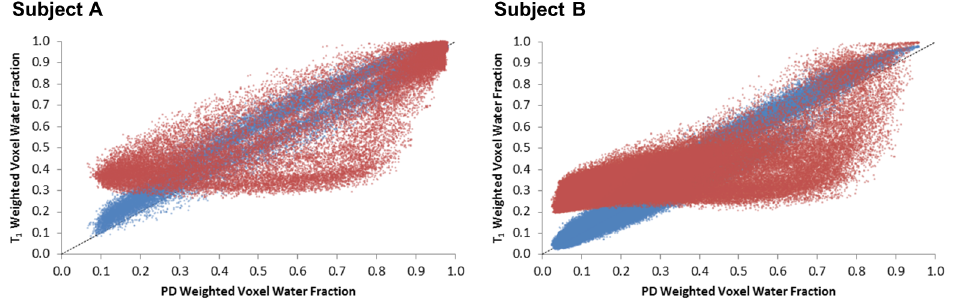
Fig 5. Low resolution voxel water fractions in corrected GRE and SE T 1 -weighted data vs . corrected GRE PD-weighted data ( blue and red , respectively ) for the right breast of two subjects. There is an approximately linear relationship between corrected GRE T1 and PD data, but a pronounced deviation of corrected SE T1 voxel water fractions from lower GRE PD values; A) 26 year old volunteer with 64.6% FGT and B) 50 year old volunteer with 18.4% FGT.